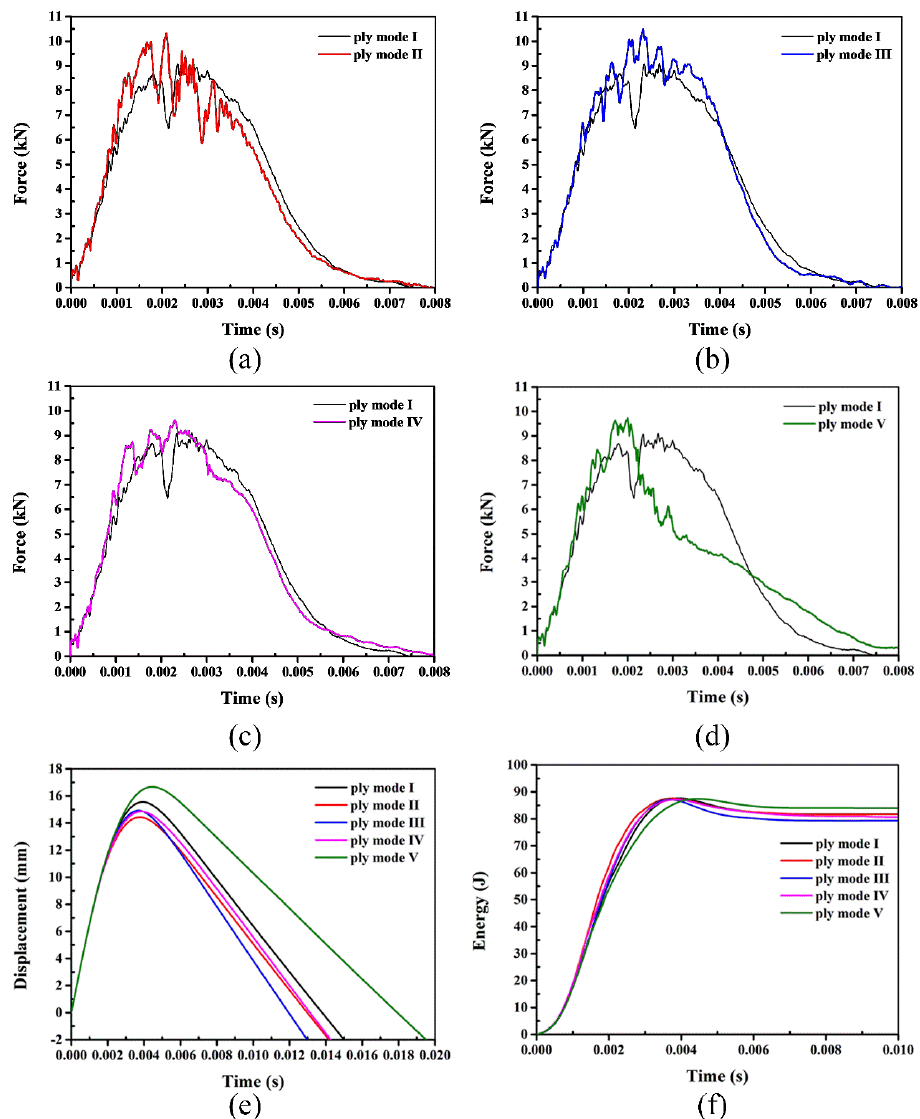
Figure 11. Typical impact behavior of laminates with 90 J (Figures ( a – d ) show the force-time curves of mode I with mode II, mode III, mode IV and mode V, respectively. Figure ( e ) and Figure ( f ) represent the displacement-time and energy-time histories of different modes,